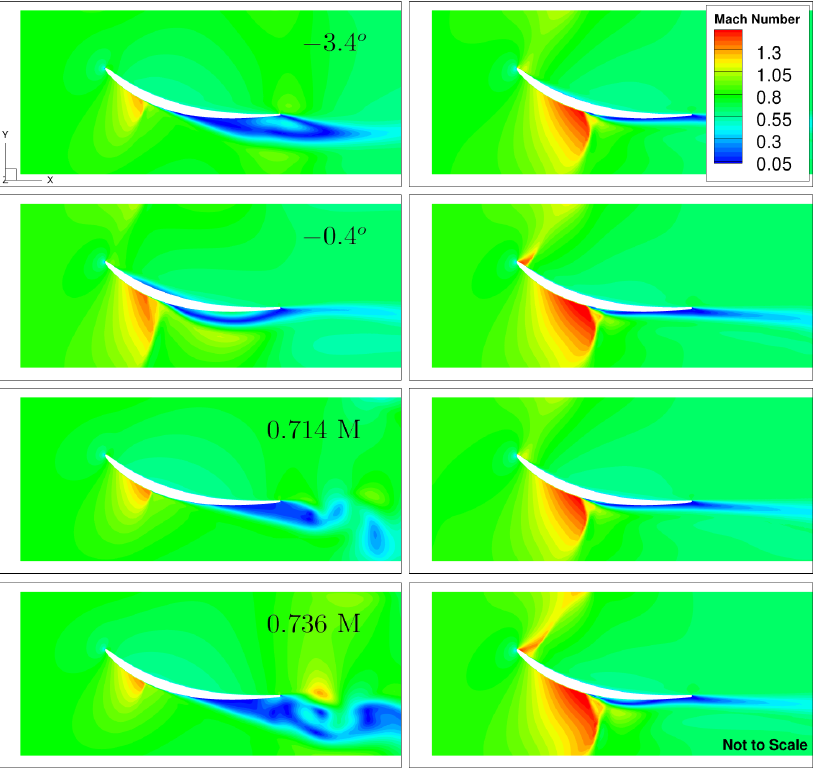
Figure 12. Instantaneous full-pitch midspan unsteady flow fields of interest.